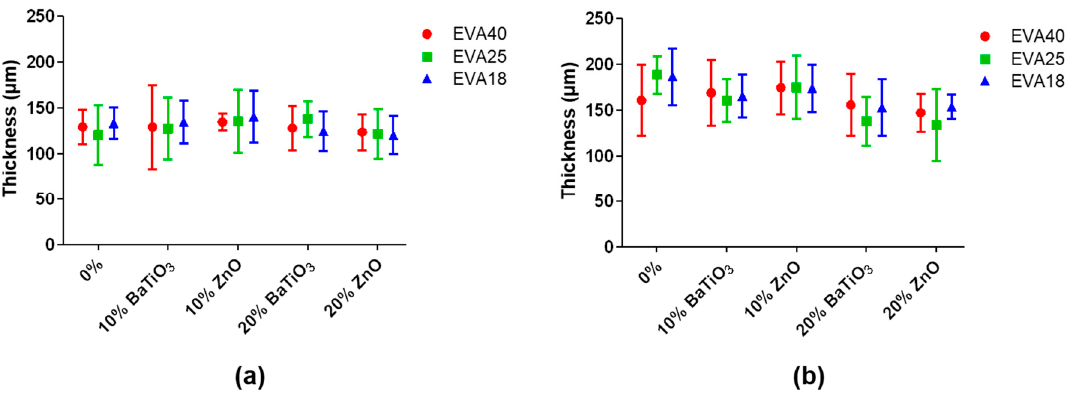
Figure 1. Thickness of the nanocomposite ethylene vinyl acetate (EVA) thin film for the EVA concentration of 5% wt. ( a ) and 10% wt. ( b ).